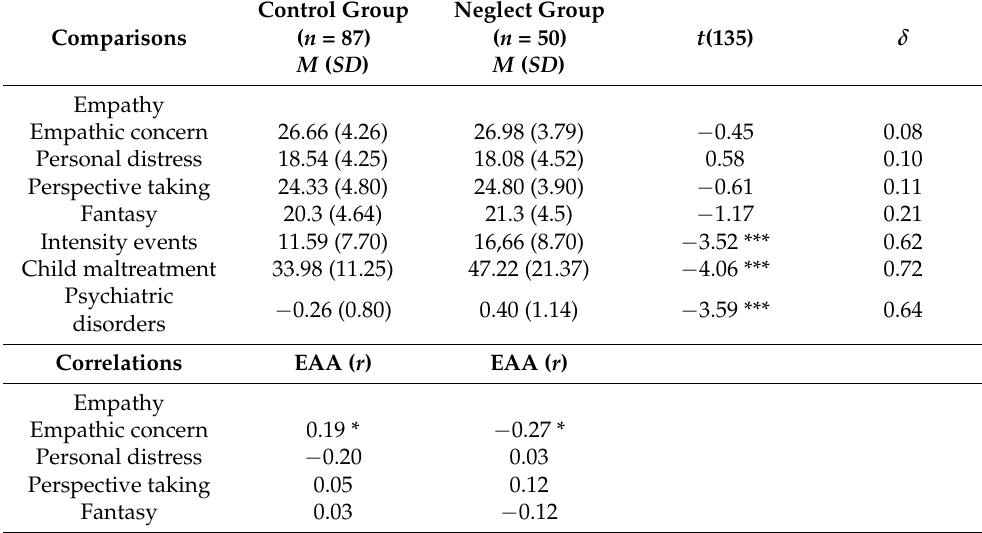
Table 2. Group comparisons of the psychological variables and correlations to epigenetic age acceleration